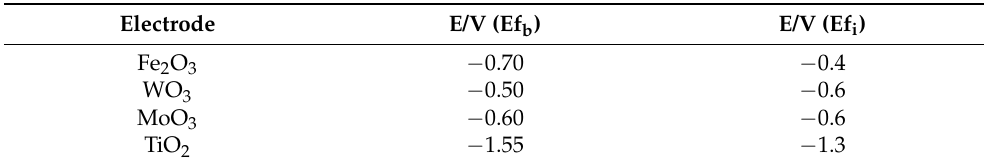
Table 1. Initial and flat band potential for TMO electrodes. Potentials were measured versus an Ag/AgCl/KCl sat reference